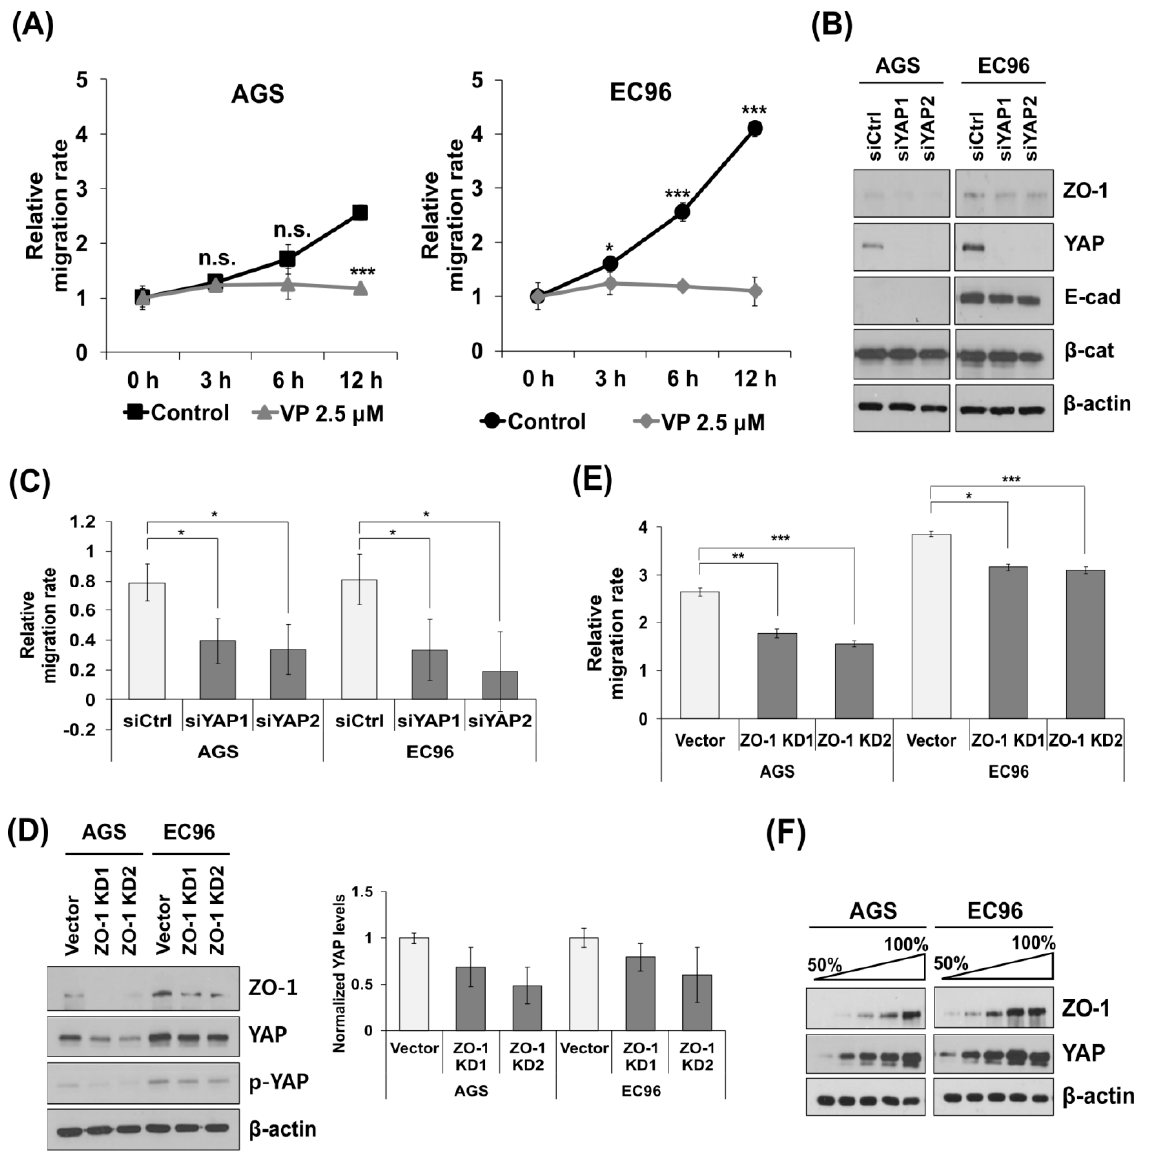
Figure 2. YAP and ZO ‐ 1 regulate cell migration. ( A ) AGS and EC96 cells were treated with 2.5 μ M verteporfin (VP) for 24 h and subjected to cell migration assay. ( B , C ) AGS and EC96 cells were transfected with siYAP RNA and subjected to immunoblot analysis using the indicated antibodies ( B ) or cell migration assay ( C ). ( D , E ) AGS and EC96 ZO ‐ 1 KD cells were established from AGS and EC96 cells using a lentivirus containing shRNA targeting ZO ‐ 1. These KD cells were subjected to immunoblot analysis ( D ) and cell migration assay ( E ). Quantification using densitometry of triplicate repeats normalized to β‐ actin was performed for YAP expression (±SD, n = 3). ( F ) AGS and EC96 cells were cultivated in different confluences and subjected to immunoblot analysis. ZO ‐ 1 and YAP expression was increased in more confluent cultures. n.s. = not significant, * p < 0.05, ** p < 0.01 and *** p < 0.001.